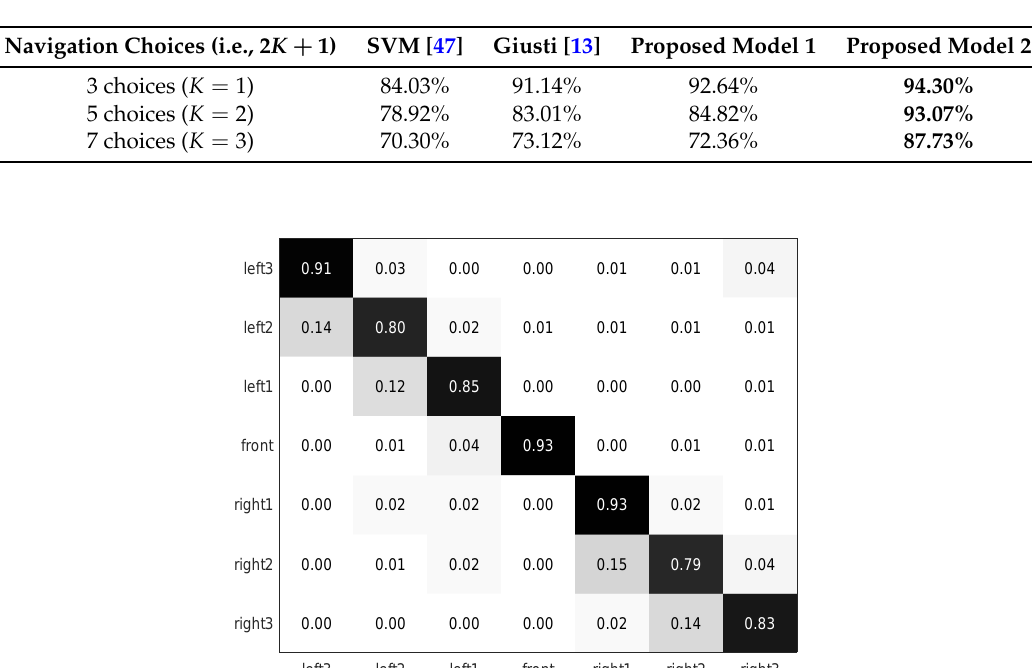
Table 2. Classification Accuracies on the Spherical-Navi dataset.